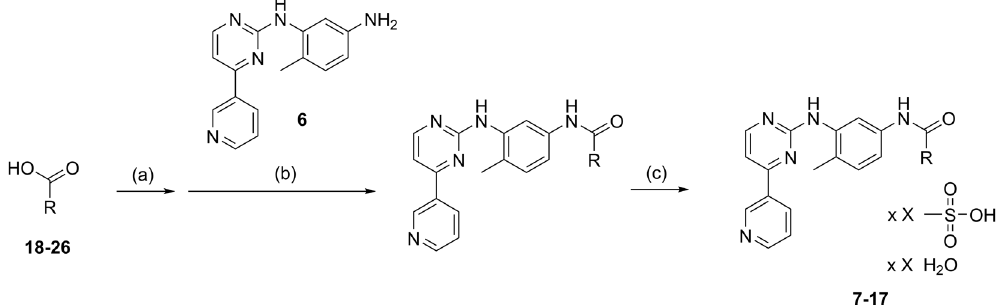
Figure 4. Synthesis of analogues 7 – 17 . Reagents & conditions. ( A ) CDI, DMF, RT, 1 h. ( B ) DMF, 80 °C, 24 h. ( c ) MsOH, MeOH, RT, 1